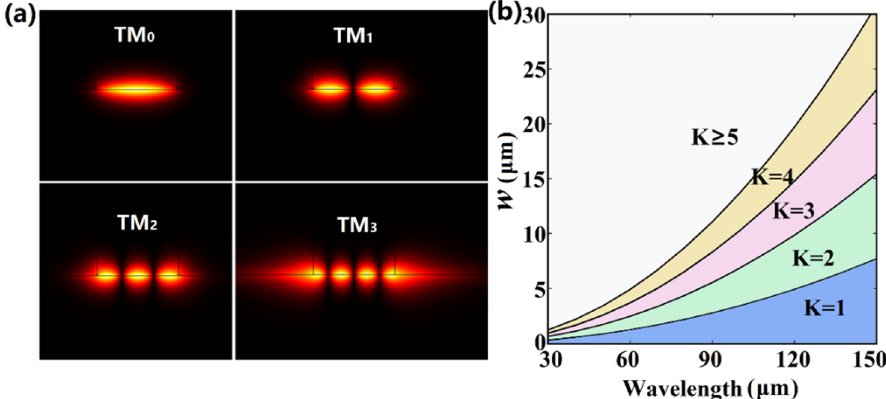
Figure 4. ( a ) Modal fields distributions (| E y | ) of the first four order modes at λ 0 = 60 μ m (5 THz) with w = 4 μ m and h = 2 μ m. ( b ) The fundamental mode and multi-modes operation regions calculated by Equation (2) as functions of the strip width w and the wavelength. K represents the total numbers of guided modes. E F = 0.6 eV.